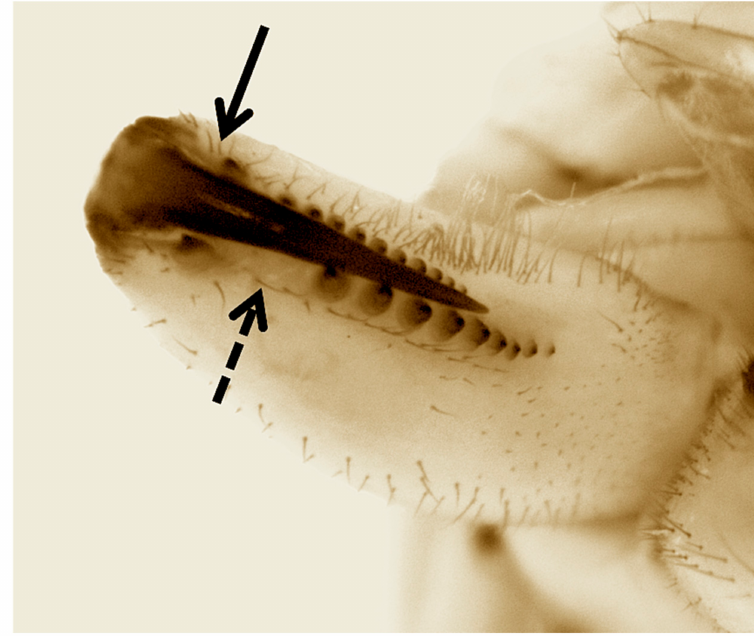
Figure 4. Inner view of left chelicerae of the sequenced female T. paschae. Complete arrow indicates the lack of the posterior cusp on the fang. Dashed arrow shows the absence of an enlarged and isolated tooth in the distal portion of the promarginal row of teeth. Both characters are present in T.